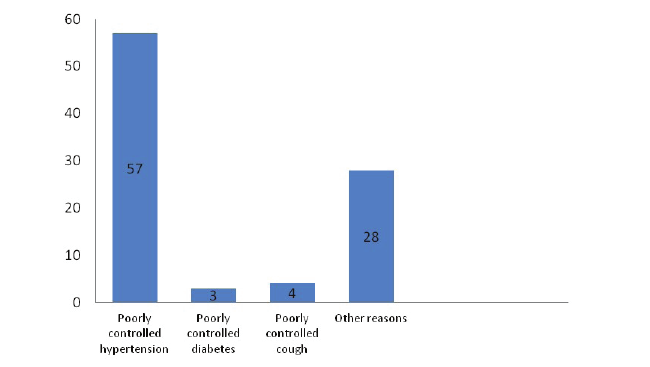
Figure 2 - Barriers to uptake of cataract surgery